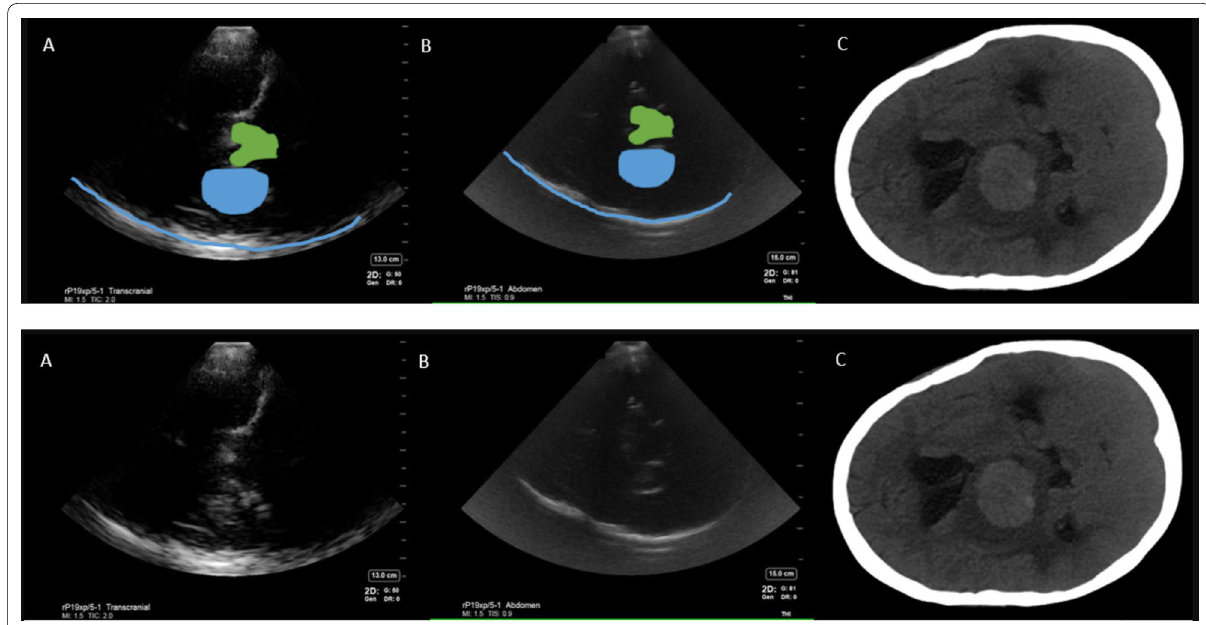
Fig. 5 Thalamic tumor creating a hyperechoic signal similar to intracerebral haemorrhage. A —Transcranial preset, B —abdominal preset, C — computed tomography (CT) brain scan. Blue line—opposite skull, green—midbrain. Blue shape outlines the hyperechoic signal corresponding to the tumor on CT scan